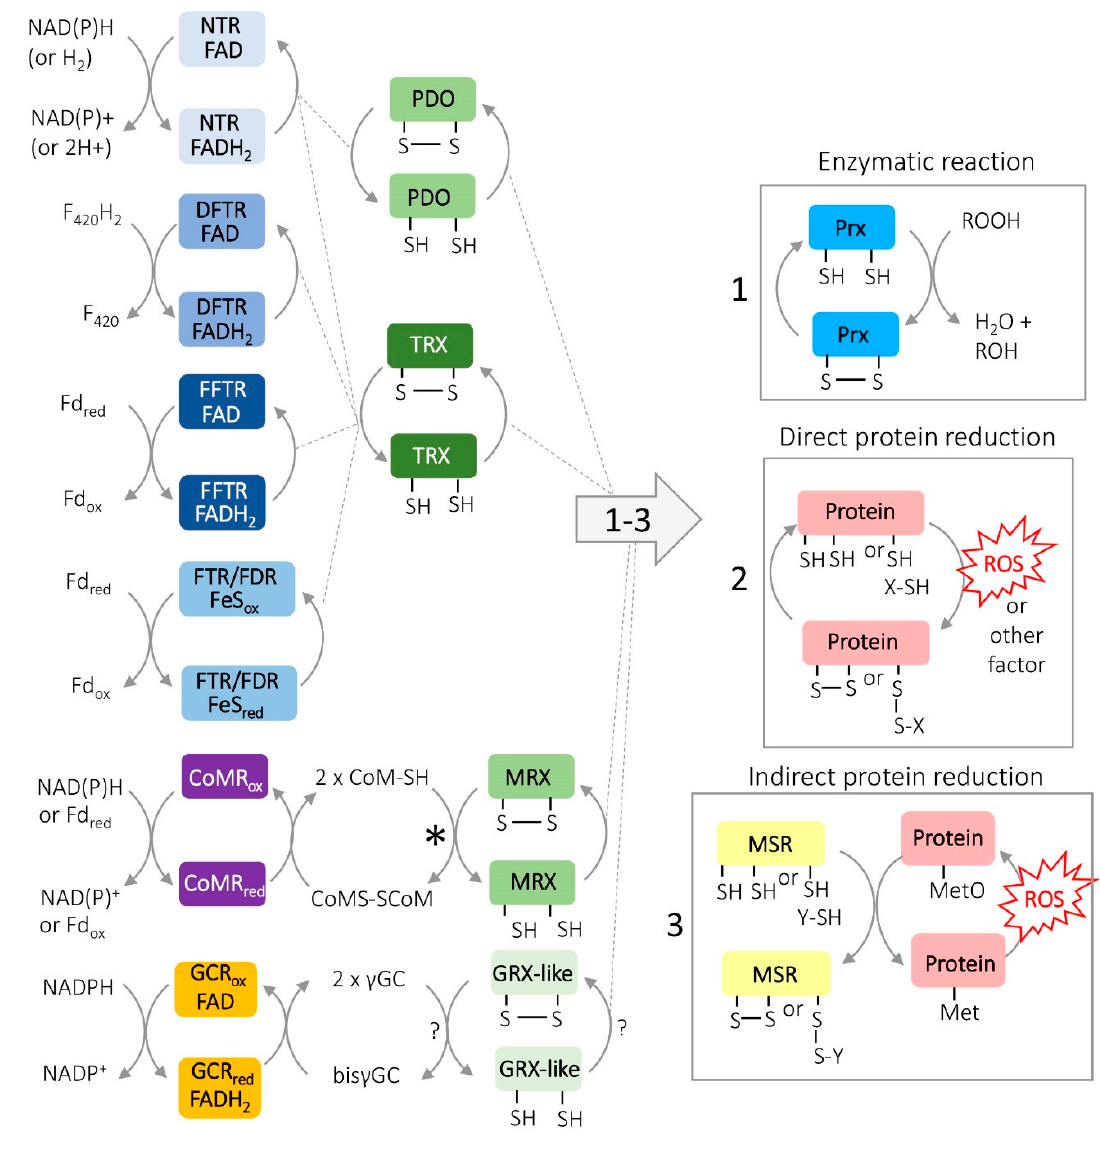
Figure 3. Protein disulfide relay systems. TRX, thioredoxin; GRX-like, glutaredoxin-like; MRX, methanoredoxin (GRX-like); and PDO, protein disulfide oxidoreducatase (GRX-like); NTR, NADPH-dependent TRX reductase; DFTR, deazaflavin (F 420 )-dependent flavin containing TRX reductase; FFTR, ferredoxin-dependent flavin TRX reductase; FTR, ferredoxin: TRX reductase that uses an active site [4Fe-4S] cluster; FDR, ferredoxin: disulfide reductase enzymes that uses an active-site [4Fe–4S] cluster; CoMR, coenzyme M disulfide reductase; CoM-SH and CoM-S-S-CoM, reduced and oxidized forms of coenzyme M; GCR, bis γ GC reductase; *, non-enzymatic reduction, ?, not demonstrated. Routes for protein thiol reductant (which may be general or specific): (1) catalytic reactions such as catalyzed by Prx, thiol-dependent preoxiredoxins; (2) direct protein reduction; and (3) indirect protein reduction such as methionine sulfoxide reductase (Msr) catalyzed reduction of methionine sulfoxide (MetO) residues on oxidized proteins; ROOH, alkyl hydroperoxide; ROH, alcohol; ROS, reactive oxygen species or other oxidant.